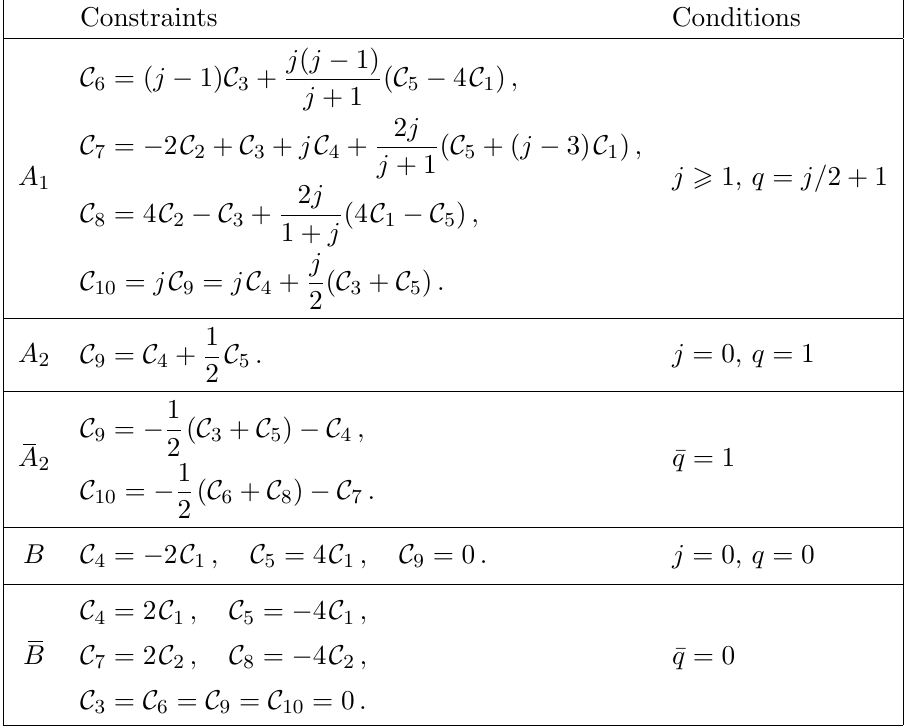
Table 2 . Constraints on the coe(cid:14)cients following from the various shortening conditions on the C k multiplet (here (cid:22) | = 0 is implicit). Case A 1 for j = 1 and cases A 2 and B for j = 0 ; 1 can be O obtained by setting to zero the absent coe(cid:14)cients ( for j = 1 and for j = 0). C 6 C 2 ; 3 ; 6 ; 7 ; 8 ; 10 all orders in (cid:18) 2 ; (cid:22) (cid:18) 2 and to all orders in (cid:18) 1 ; (cid:22) (cid:18) 1 to make some consistency checks, 17 but